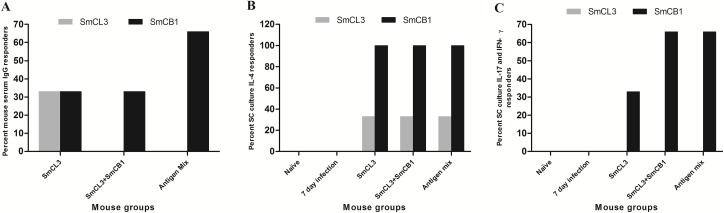
Immunogenicity of SmCL3 alone and in combination with SmCB1 and SG3PDH.(A) Percent mice with serum IgG antibody binding to SmCL3 or SmCB1 significantly (P < 0.05) higher than naïve and 7-day infection mice is represented by grey and black columns, respectively (B & C). Ex vivo spleen cells from 3 mice from each group of naïve, 7-day infection, SmCL3-, SmCL3 + SmCB1-, or SmCL3+SmCB1+ SG3PDH (Antigen Mix)-immunized mice were stimulated 7 days after infection with S. mansoni with 20 μg/ml SmCL3 (grey columns) or SmCB1 (black columns) and spleen supernatants assayed for release of cytokines by capture ELISA. Each column represents percent mouse SC culture releasing cytokine detectable levels, higher than mean of naïve and controls + 2 SD.